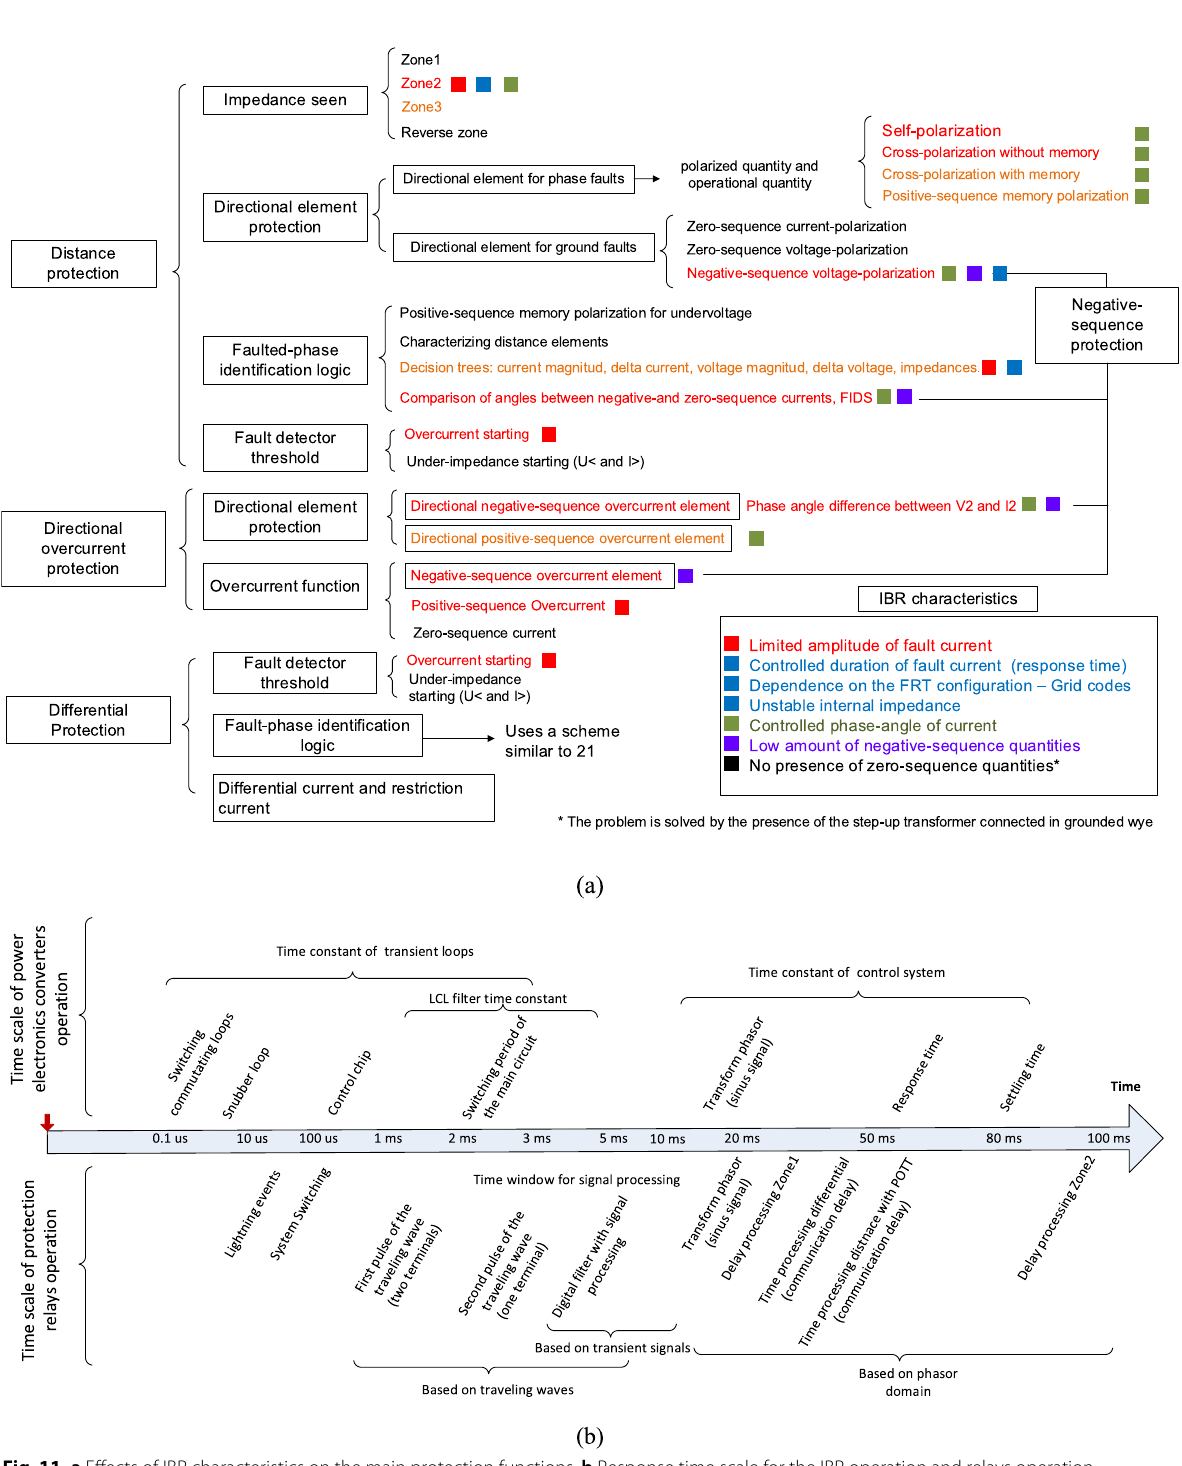
Fig. 11 a Effects of IBR characteristics on the main protection functions. b Response time scale for the IBR operation and relays